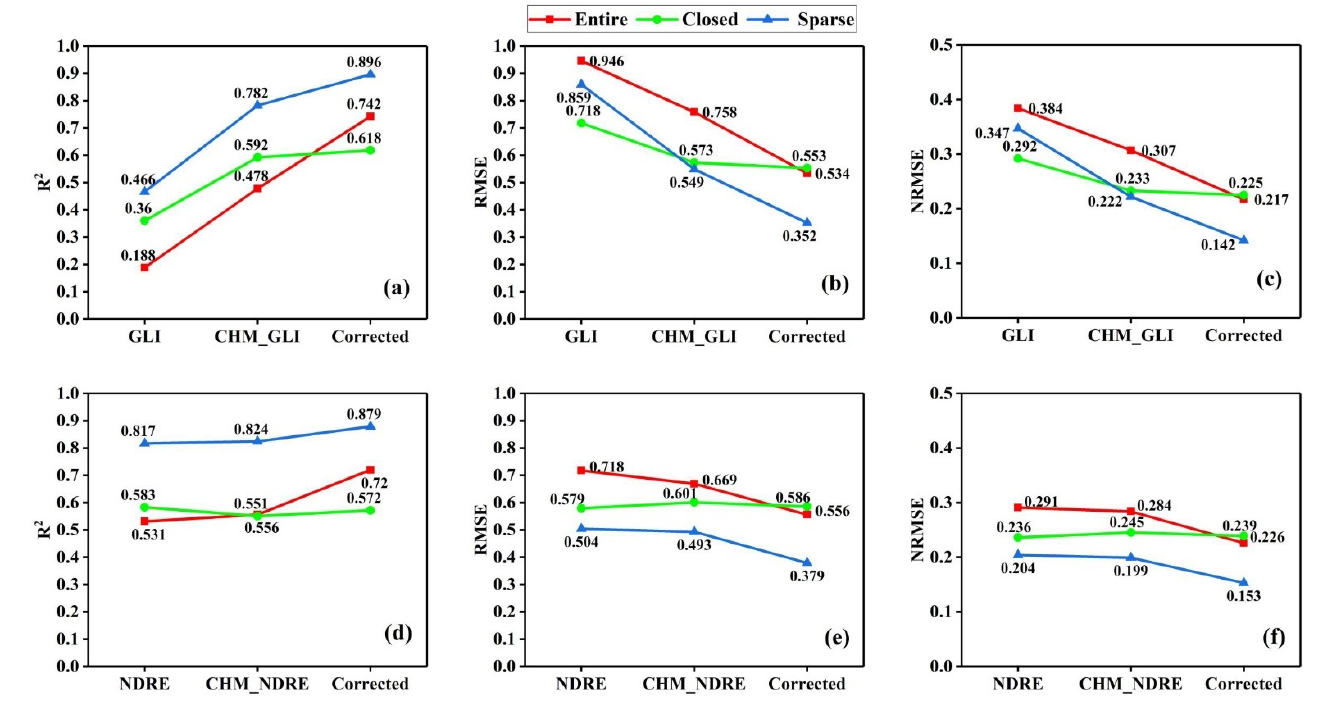
Figure 5. LAI estimation accuracy using only vegetation index and vegetation index combined with CHM and CC corrections. ( a – c ) represent R 2 , RMSE and NRMSE of LAI estimation based on GLI, respectively; ( d – f ) represent R 2 , RMSE and NRMSE of LAI estimation based on NDRE, respectively.